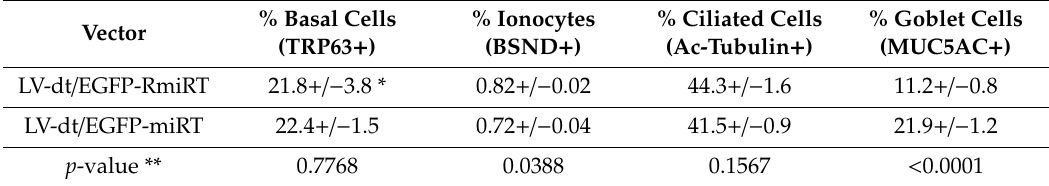
Table 1. Distribution of cell types in di ff erentiated ALI